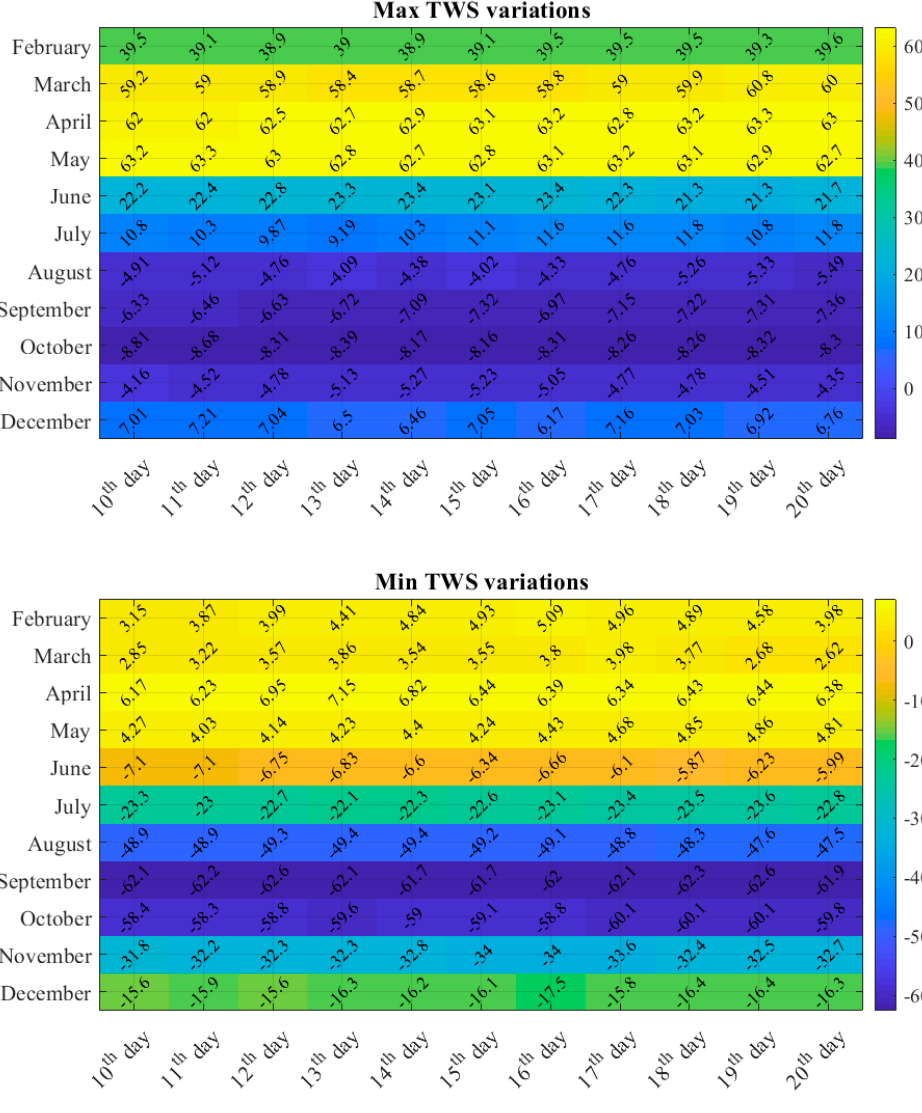
Figure 8. Daily fluctuations of GRACE terrestrial water storage anomalies (TWSA) in different locations (pixels) after downscaling between the 10th and 20th day of each month from February to December 2003 [mm].